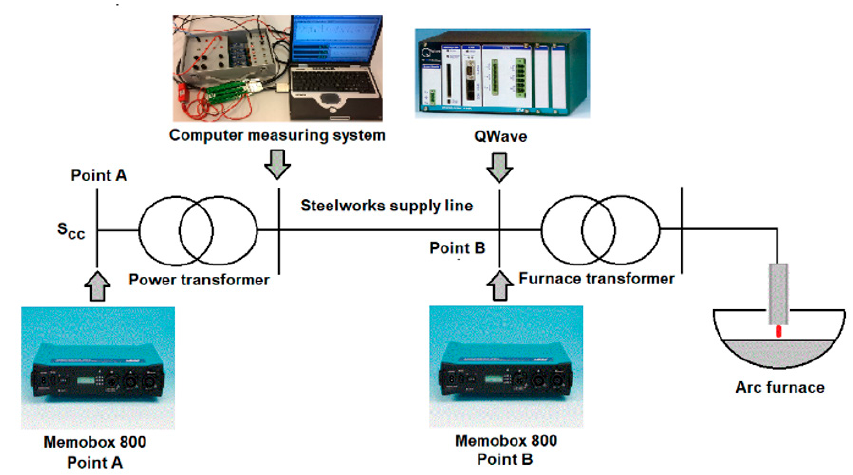
Figure 1. Places to measure indicators characterizing the quality of electricity.